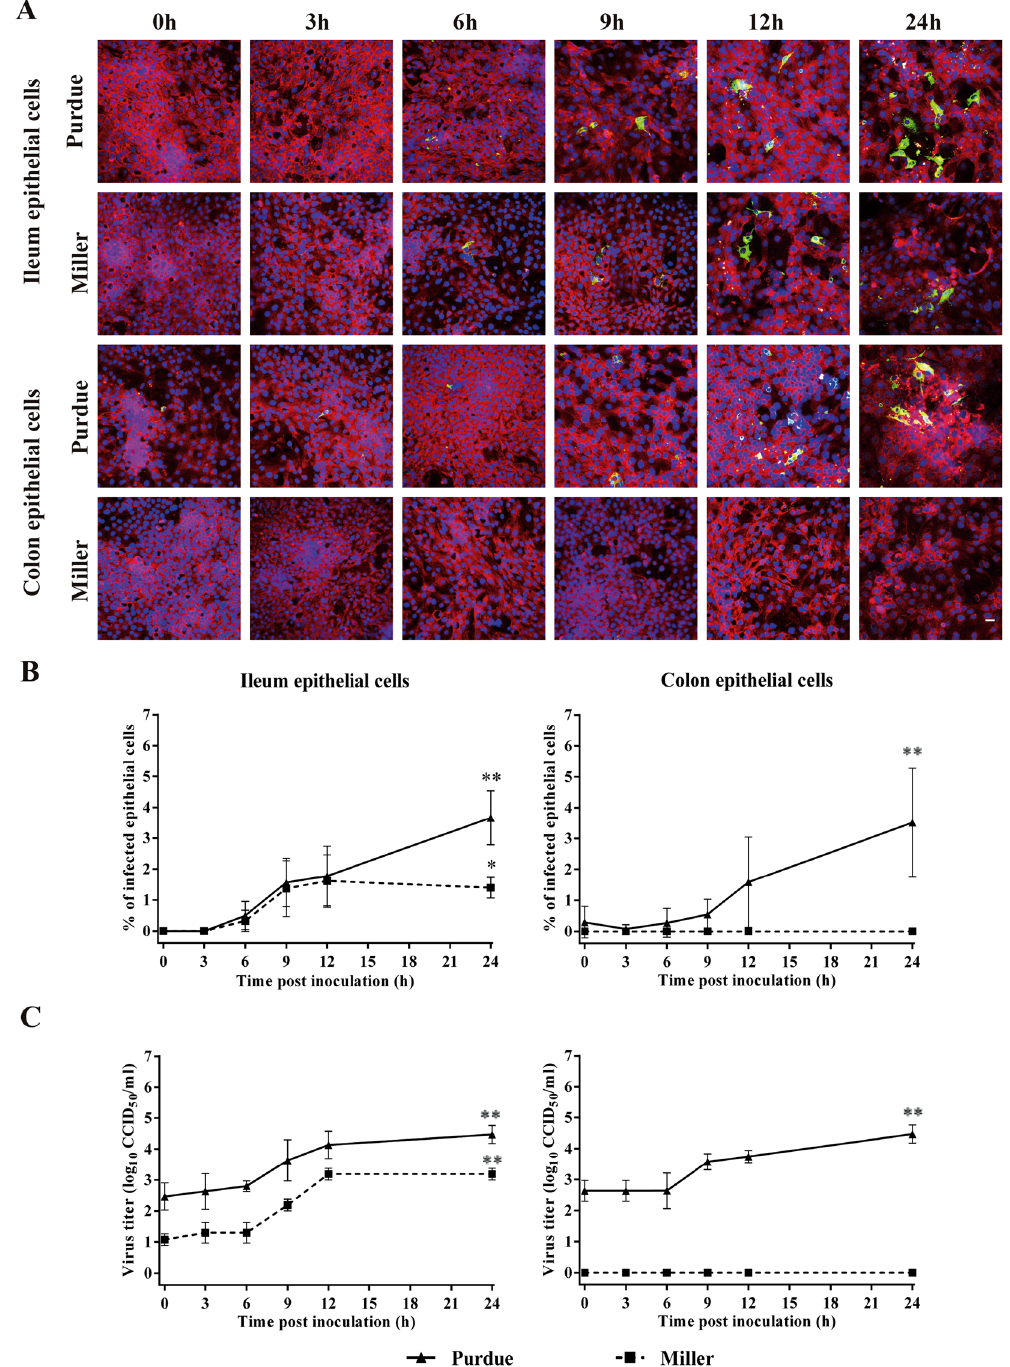
Figure 8. Kinetics of TGEV replication in ileum and colon epithelial cells co-cultured with myofibroblasts. Three days post co-cultivation, cells were inoculated with TGEV strains Purdue and Miller at an m.o.i. = 1. At different time points post inoculation, ( A ) infected cells were visualized by immunofluorescence staining (red represents cytokeratin and green represents TGEV antigen positive cells) and ( B ) the percentage of infected epithelial cells and ( C ) virus titers in the supernatant were determined. Scale bar: 25 µ m. Data are expressed as mean ± standard deviation of the results of 3 separate experiments. Statistically significant differences in comparison with the data from 0 h p.i. are represented as * P < 0.05 or ** P <